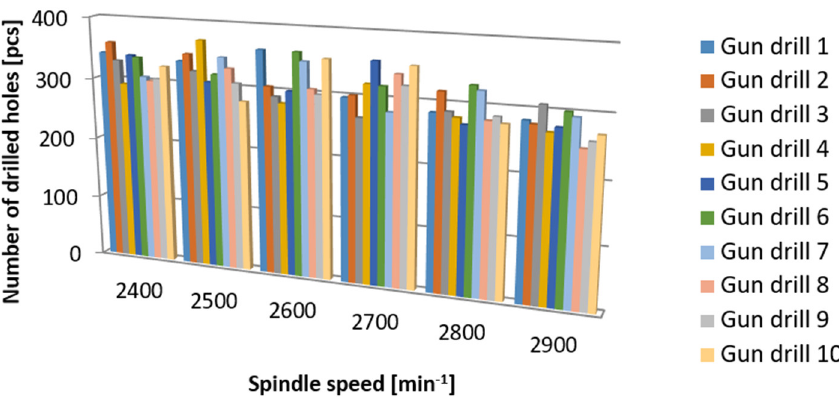
Figure 6. Plotted number of holes drilled up to the moment the tool was damaged when the speed changed and the feed rate remained constant.